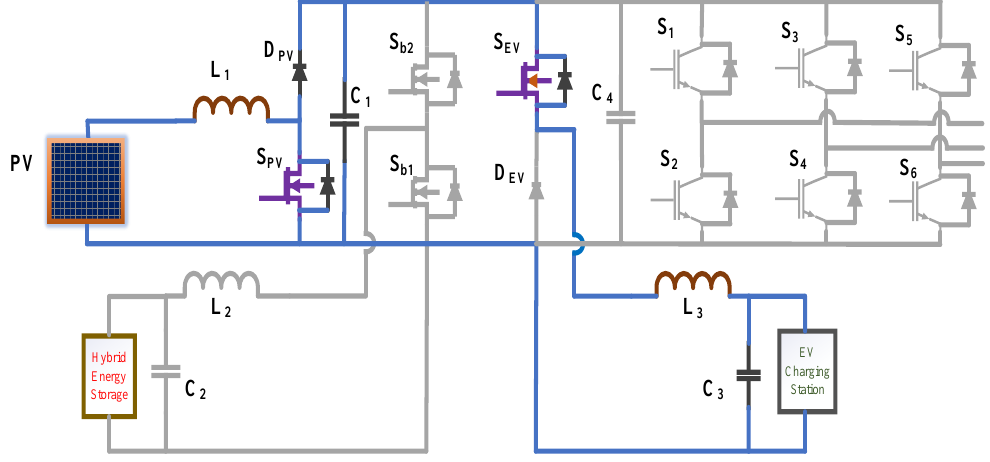
Figure 6. Power flow from PV to EV Charging